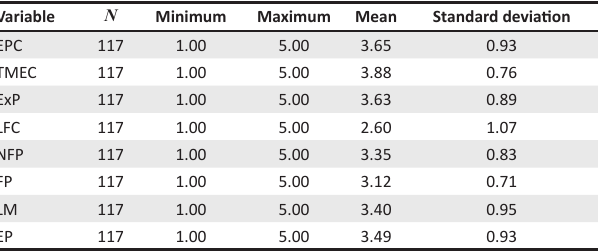
TABLE 6: Descriptive statistics.